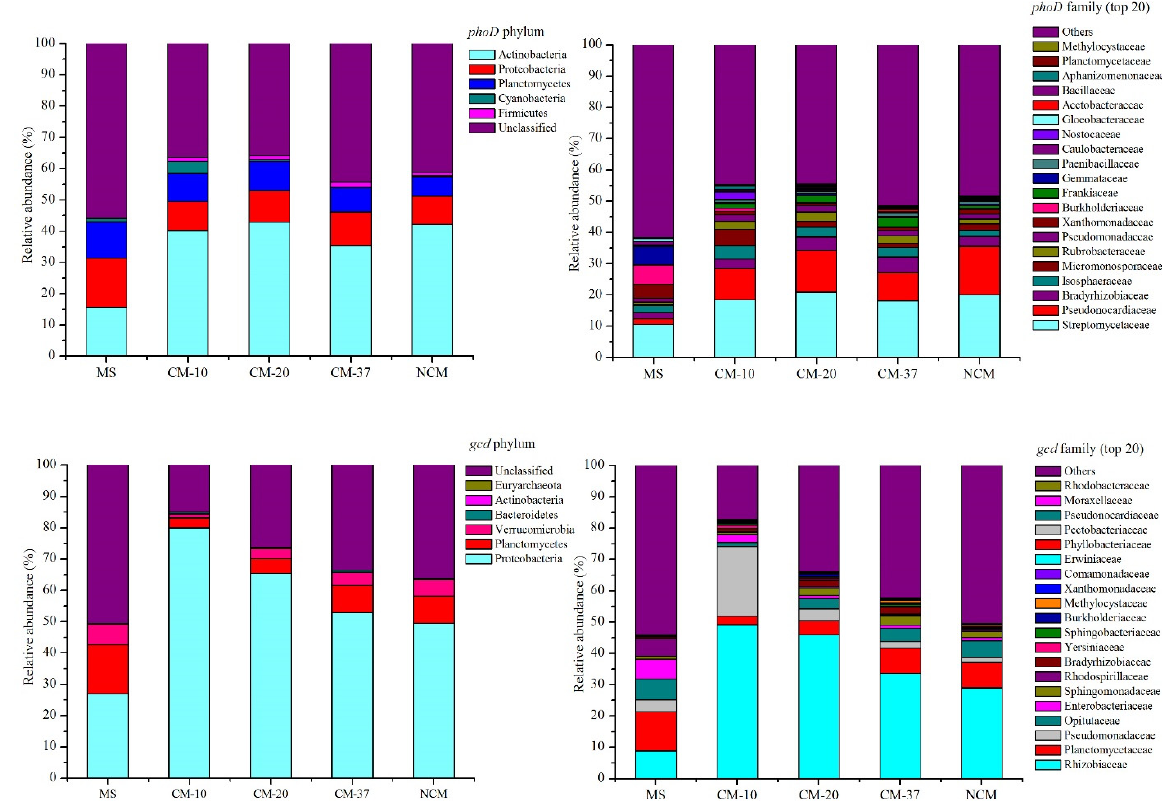
Figure 5. Relative abundance of dominant phyla and families of phoD and gcd -communities (average of three plots).